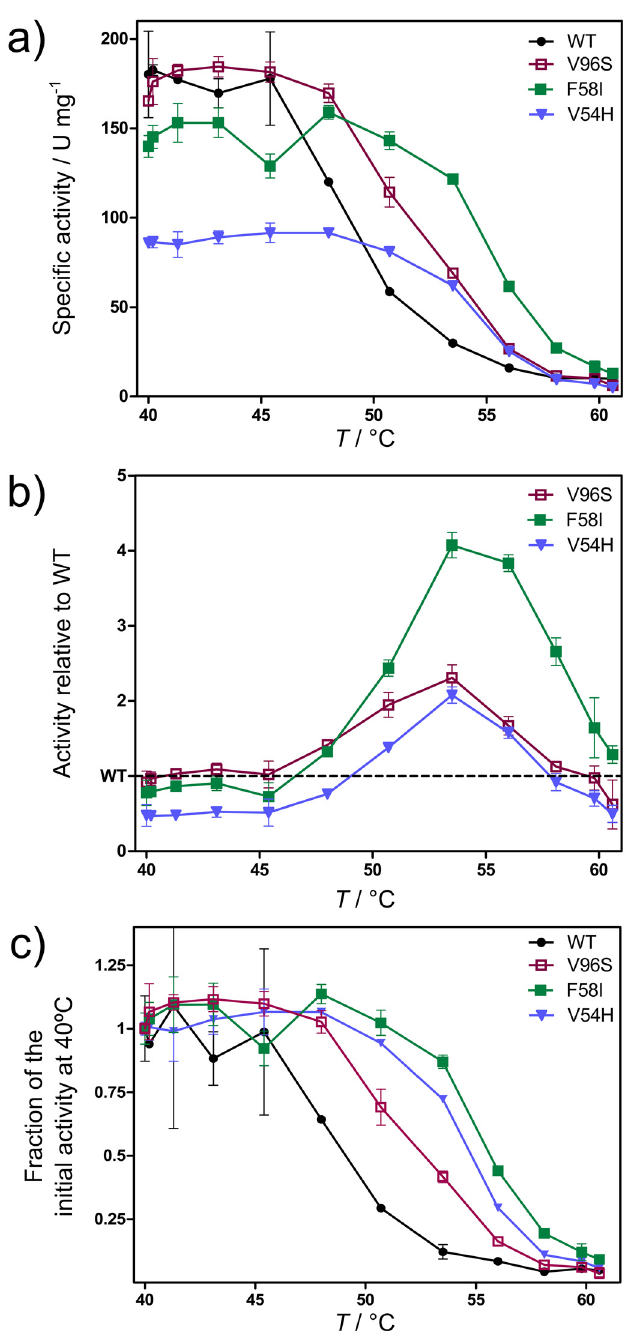
Fig 3. Thermostability of WT (black) and variants V54H (blue), F58I (green), and V96S (red) shown as activity vs . temperature curves. The activity was measured at indicated temperatures after incubating for 30 min at these temperatures. Curves show absolute specific activity (a), activity normalized by the activity of WT (b), and the fraction of the activity to the initial activity at 40°C (c).